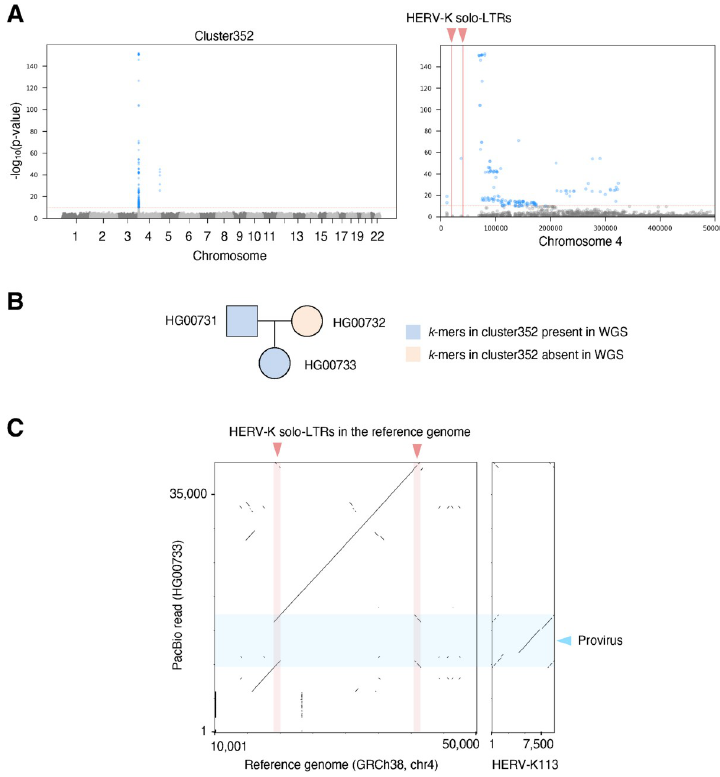
Fig 6. K -mer-based method detects previously-unreported HERV-K polymorphism in subtelomere. A. SNVs associating with k -mers in cluster352. The right panel shows the region near the end of the p-arm of the chromosome 4. SNVs with p-value lower than 8.33e-11 are shown as blue dots. The red solid lines in the right panel show two reference HERV-K solo-LTR in the subtelomere region. B. Presence and absence of k -mers of cluster352 in the public high-coverage short-read WGS of the Chinese trio. C. HG00733 contains non-reference provirus. Left panel shows the dot matrix between the reference human genome and a PacBio read of HG00733. The right panel shows the dot matrix between the reference HERV-K113 and the PacBio reads of HG00733. Light blue and light red rectangles represent HERV-K provirus and solo-LTR, respectively.